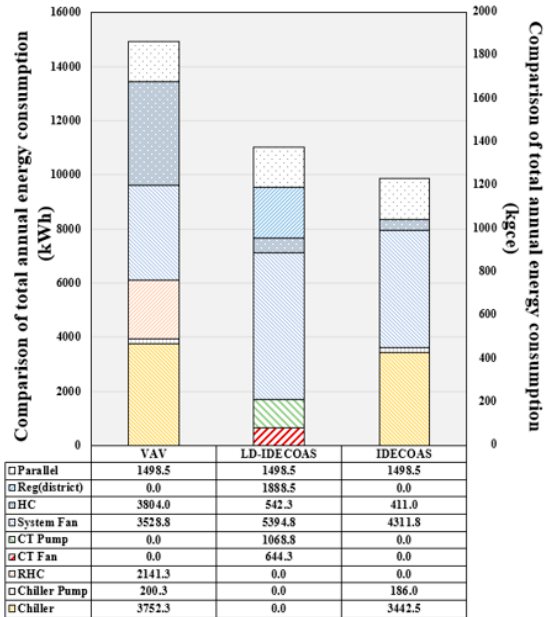
Figure 22. The total annual energy consumption of each system in the Kunming region.